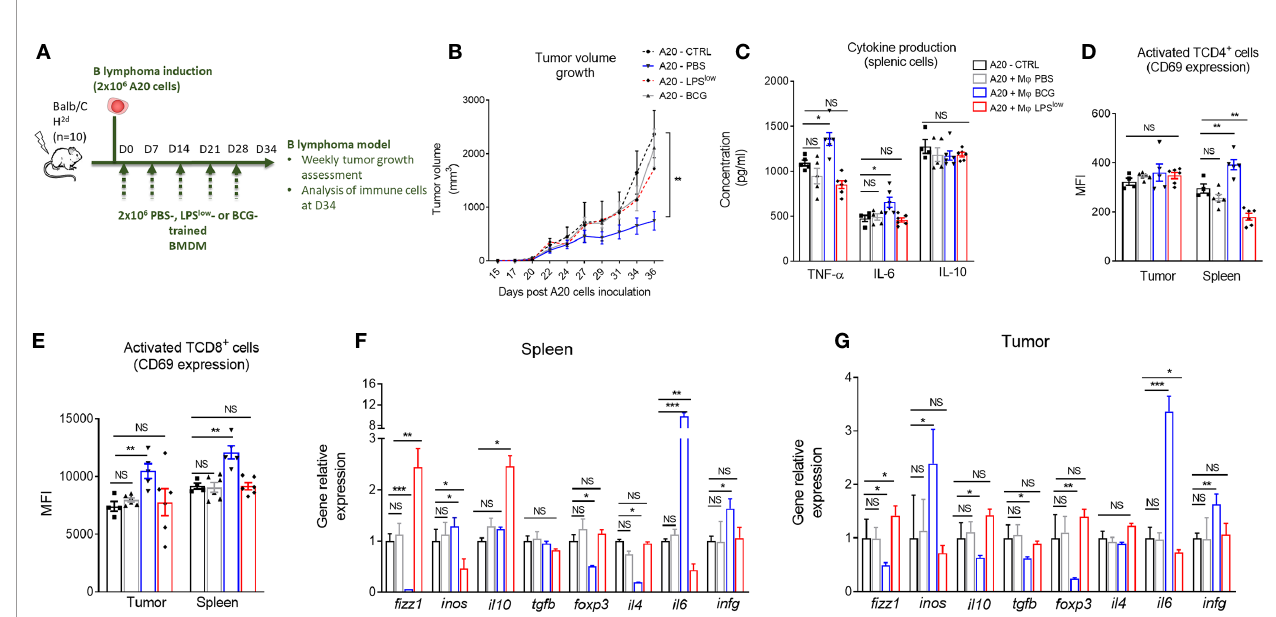
FIGURE 8 | Clinical and immunological impact of the adoptive transfer of trained-macrophages on A20 cells B lymphoma tumor growth in mice. (A) Schematic representation of the in vivo induction of B lymphoma in mice and scheduling of trained macrophage infusion. Mice (n = 7 in each group) were subcutaneously injected with 2 × 10 6 A20 cells and sacri fi ced at day 34 in one experiment. (B) Tumor volume evolution in the different groups of A20-challenged mice (n = 7). Tumor growth was monitored three times a week with a microcaliper, and tumor volumes were calculated as length × width 2 × 0.5236 and expressed in mm 3 . Statistics are shown between the BCG-macrophages infused (A20-BCG) and the untreated A20 groups. Differences were detected at sacri fi ce using the Mann – Whitney test. **p ≤ 0.01. (C) Cytokine production in the supernatant of splenic cells harvested at sacri fi ce, stimulated with 5 m g/ml of Concanavalin A and incubated for 48 h at 37°C with 5% CO 2 . Levels of TNF- a , IL-6, and IL-10 were assessed by ELISA and concentrations are expressed in pg/ml. Data represent the mean ± SEM from the duplicate of at least n = 5 biologically independent samples. (D, E) Flow cytometric analysis of splenic and tumoral CD4 + (C) and CD8 + (D) T-cell phenotype at day 34 of the experiment. Tumor in fi ltrating T cells were gated on CD3 and CD4 or CD8 positive cells among CD45 positive population. Data represent the mean fl uorescence intensity of CD69 ± SEM, re fl ecting the activation status of the assessed cells, obtained from at least n = 5 biologically independent samples. (F, G) RT- qPCR assessment of fi zz1 , inos , il10, tgfb , foxp3 , il4 , il6 , and infg mRNA levels in the spleen and tumor lesions of the different groups of A20-challenged mice at day 36 of the experiment. Results were expressed as fold increase versus the untreated A20-mice group, derived from at least n=5 biologically independent samples. Unpaired T-test was used to detect the differences between the groups. NS, non-signi fi cant; *p ≤ 0.05; **p ≤ 0.01; ***p ≤